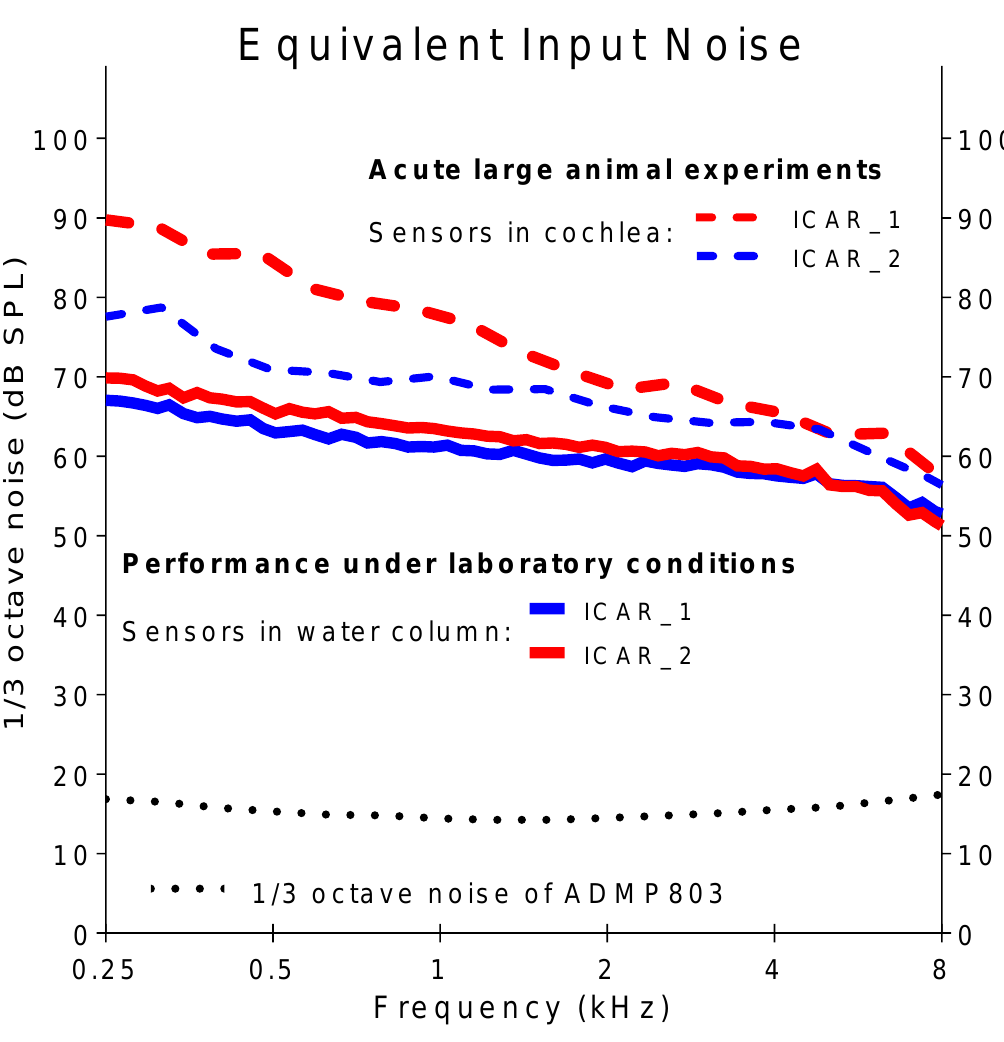
Figure 3. Equivalent input noise (EIN) of the ICARs under laboratory conditions (solid lines) and during acute large animal experiments (dashed lines).